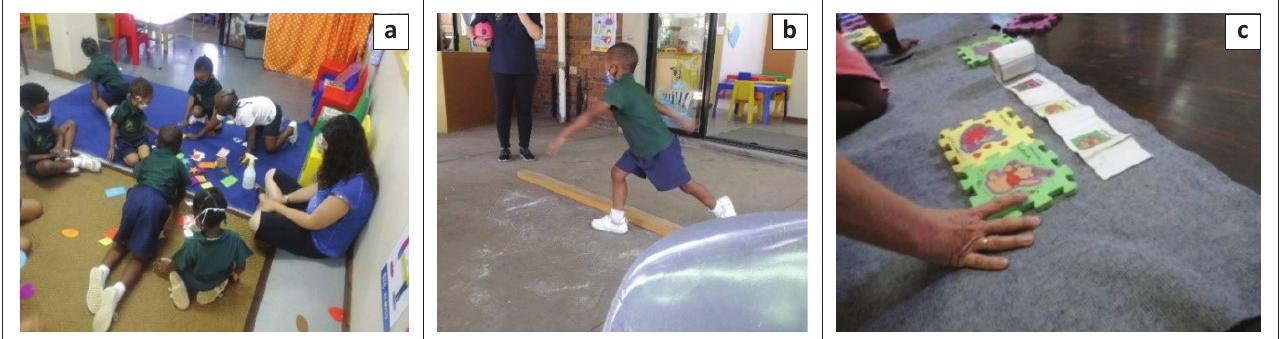
FIGURE 2: The demonstration of teachers’ roles during structured play (a,b,c) in a Montessori classroom (Etokabeka